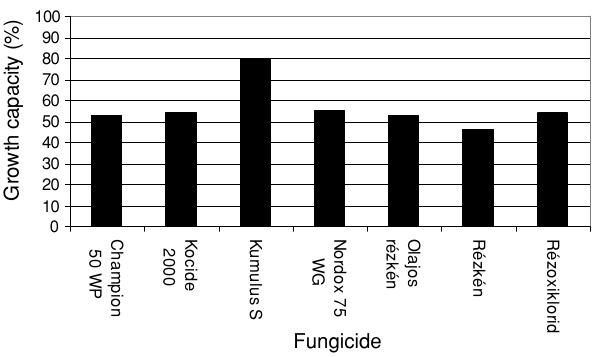
Figure 3. Percent growth capacity of Spilocaea pomi for 7 fungicides (organically approved) admended on PDA plates at 0.5 × dosage recommended by the manufacturer (LSD